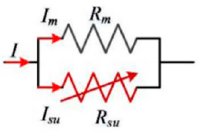
Figure 3. Schematic diagram of shunt under overcurrent condition.